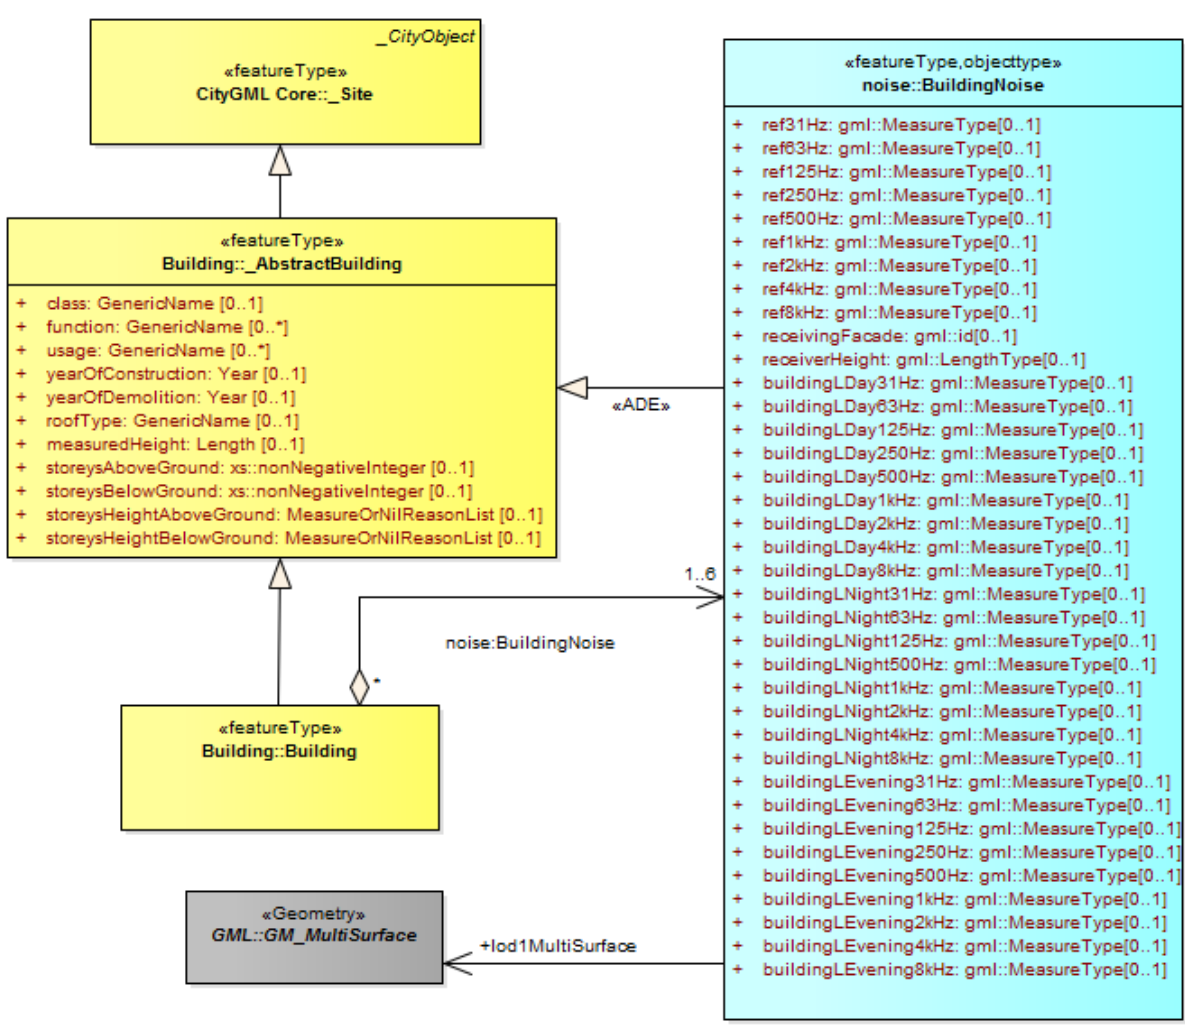
Figure 9: Extended CityGML Noise ADE UML for buildings (light yellow=CityGML Transportation module, light blue=Extended CityGML Noise ADE) (We removed the existing noise attributes for easy